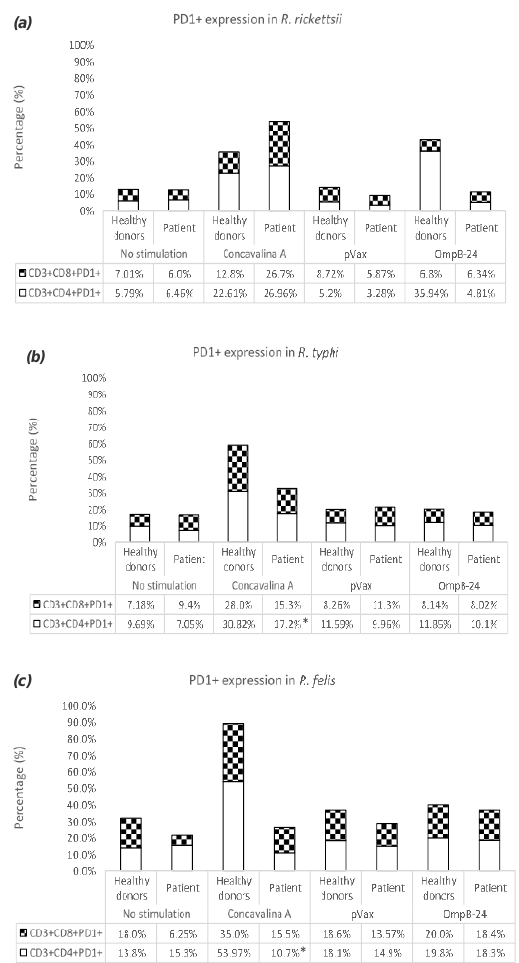
Figure 4. PD1 expression in T lymphocyte subpopulations. Percentage of TCD4+PD1+ and TCD8+PD1+ cells in healthy donors and patients post-infection with R. rickettsii ( a ), R. typhi ( b ) and R. felis ( c ), stimulated or not with ConA, pVax and OmpB- 24 for 24 h. Values show the average of 5 samples. (*) p - value ≤ 0.05 calculated with the Student's t -test.